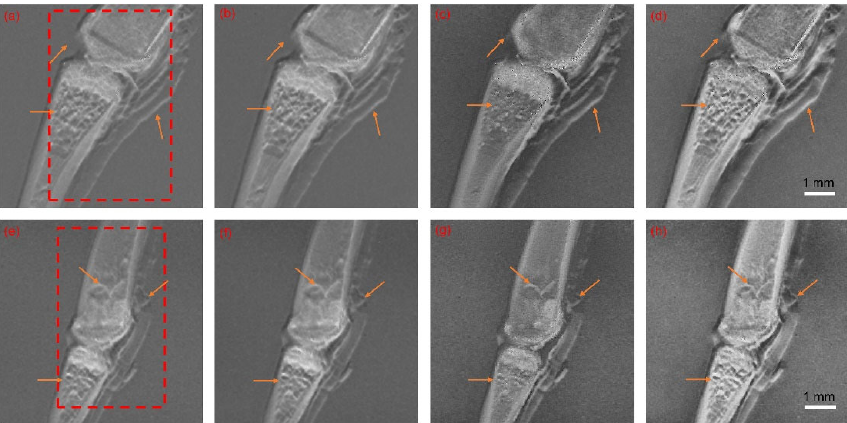
Figure 5. Fusion results of ( a , e ) NSCT, ( b , f ) NSCT-PCNN, ( c , g ) SIDWT, and ( d , h ) the proposed method (NSCT-SCM). The red boxes denote the region of interest used to calculated objective evaluation criteria. The orange arrows point out distinct differences between results of image fusion methods.